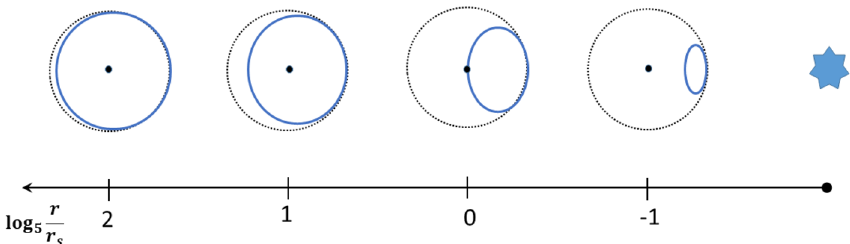
Figure 2. The geometry of the influenced spacetime in the vicinity of a Black Hole. At each distance, we see the 0 = 1 2D section of the light cone at u in flat spacetime (black) and influenced spacetime